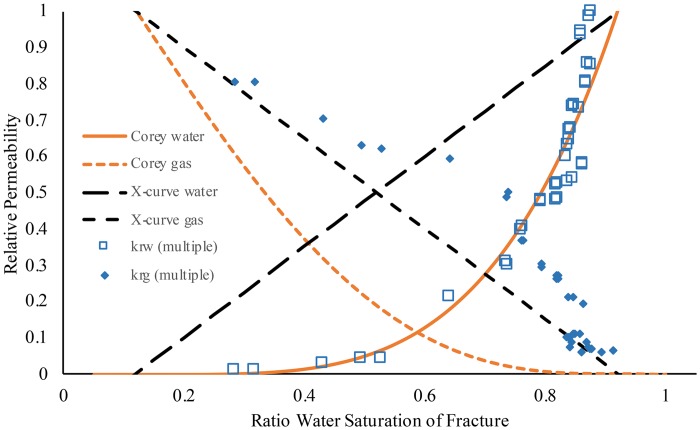
Relative permeability plot of multiple fracture cement cylinder.Water (open squares; 0.1 M NaNO3; krw) and air (closed diamonds; air; krg) were from a paired relative permeability experiment. Solid line and dashed orange line is the Corey-curve and dashed black lines are the X-curve respectively for relative permeability.